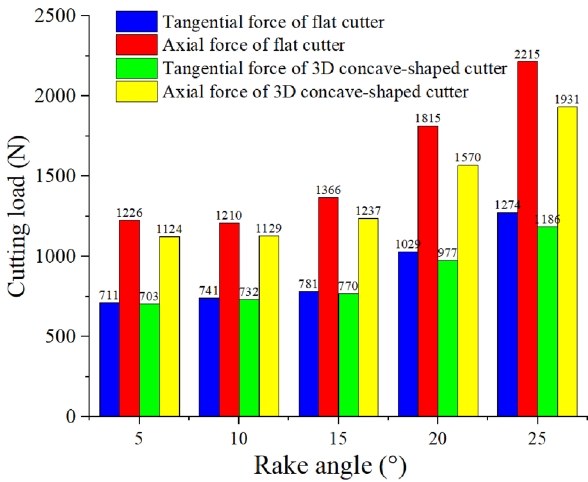
Fig. 14 Changes in cutting load with different rake angles